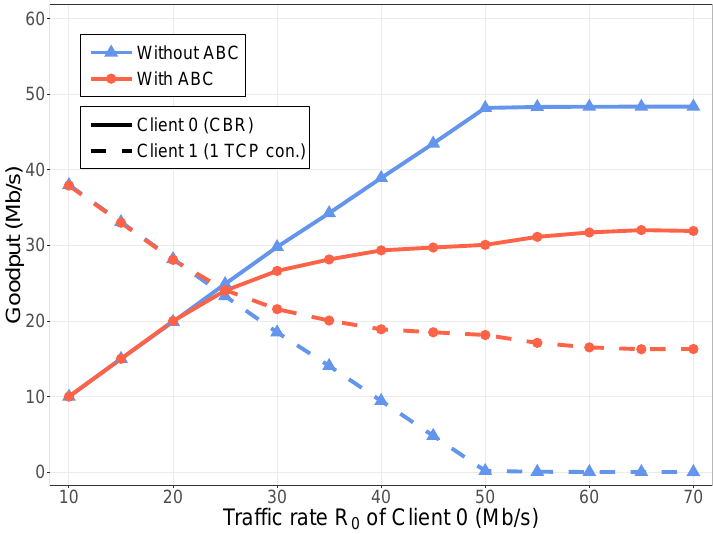
Figure 6. Resource sharing with CBR and TCP traffic; Client 0 sends CBR traffic as indicated on the x -axis while Client 1 has one saturated TCP